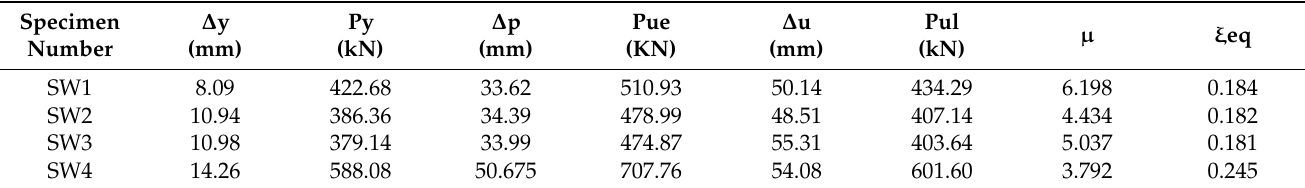
Table 4. Summary of test